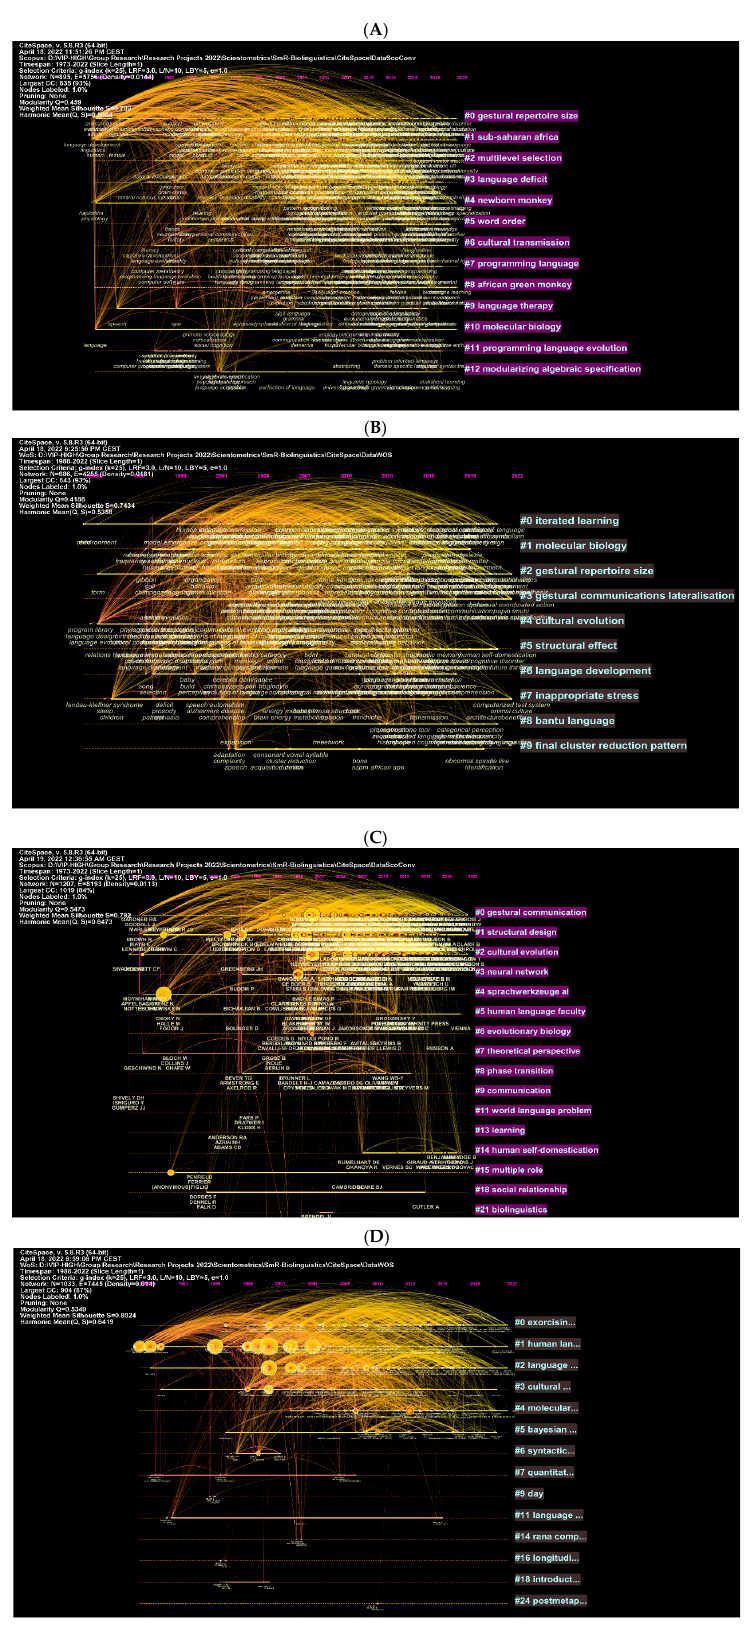
Figure 9. Top keywords, cited authors and clusters in biolinguistics. ( A ) (Scopus), ( B ) (WOS), ( C ) (Scopus), ( D ) (WOS). Another important factor is the cooccurrence of used keywords. Using VOSviewer, we generated three visual network maps for the occurrence of the most used keywords in biolinguistics in the three databases (Figure 10A–C). Each colour represents one direction for the study of biolinguistics. For instance, green shows topics related to cognitive histor- ical linguistics, blue to gesture and vocal learning multimodal (see Figure 10A). These colours change according to the database. For instance, in Figure 10B, green indicates lan- guage evolution, blue for biolinguistics, and purple for natural selection and phylogenet- ics. Orange in Figure 10C shows keywords related to biolinguistics. ( A ) ( B )